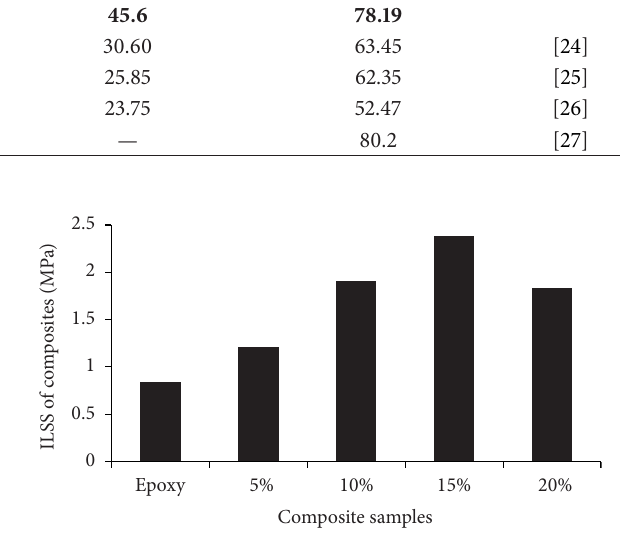
Figure 5: Effect of ILSS of